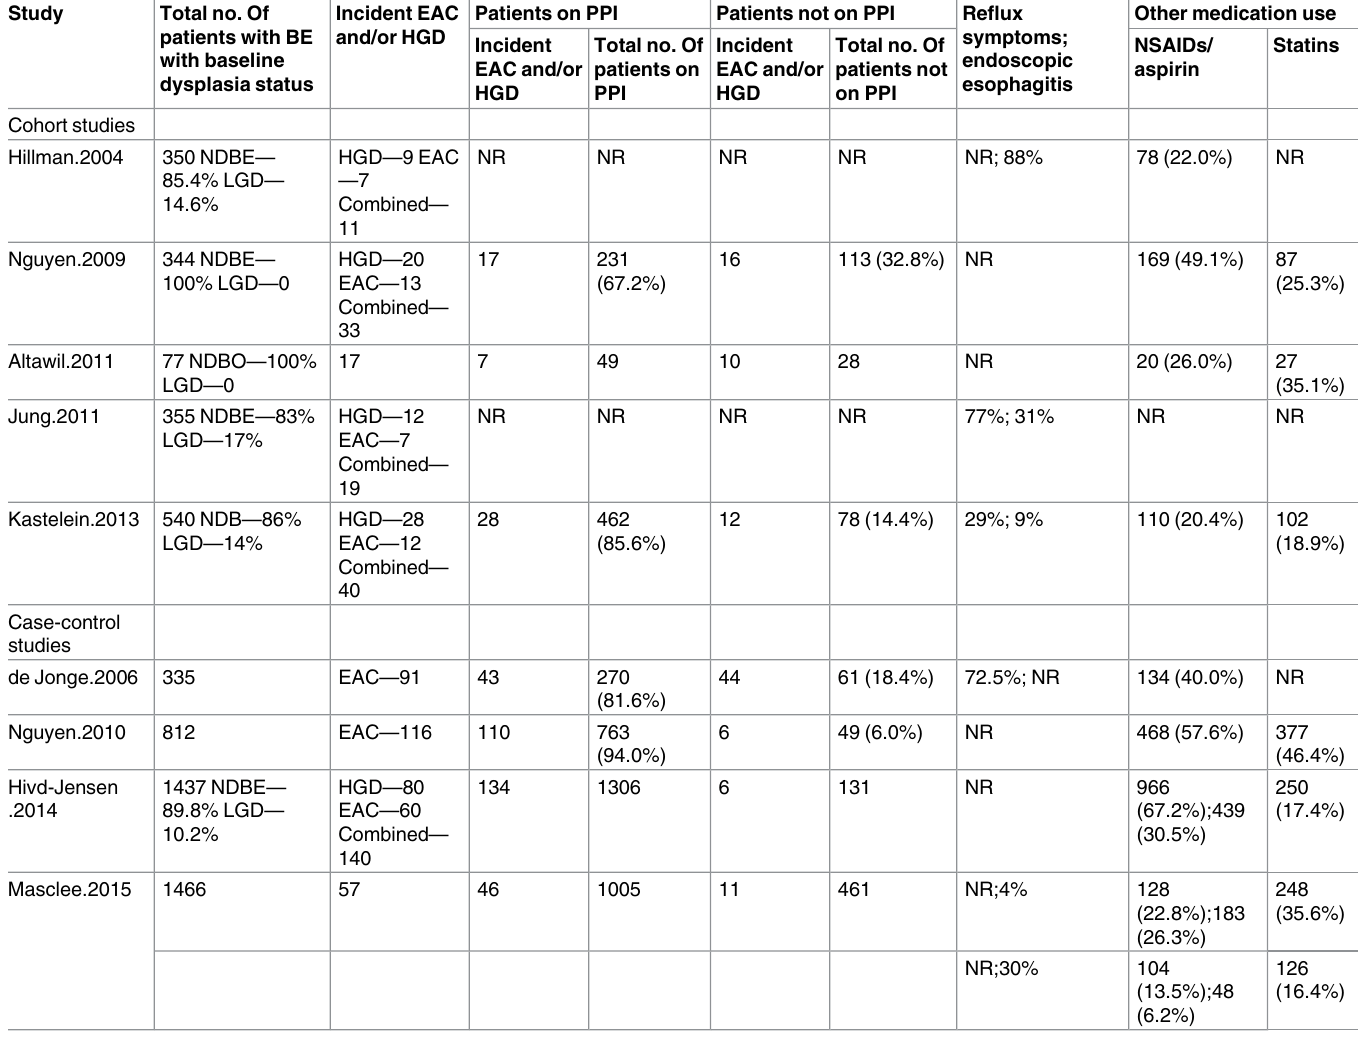
Table 2. The use of PPIs and other medication and the incidence of EAC and/or HGD in included studies.